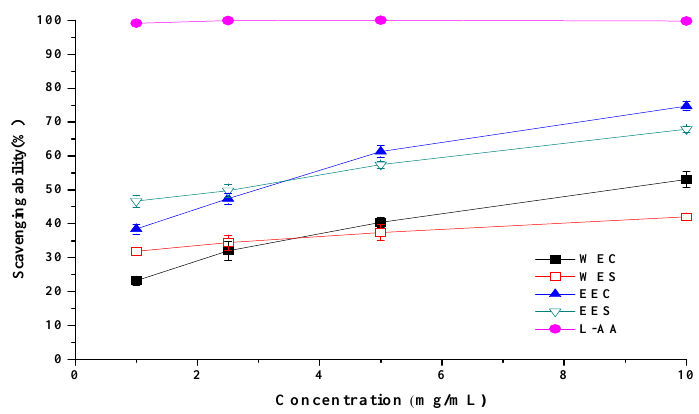
Each value is expressed as mean ± S.D. (n = 3).